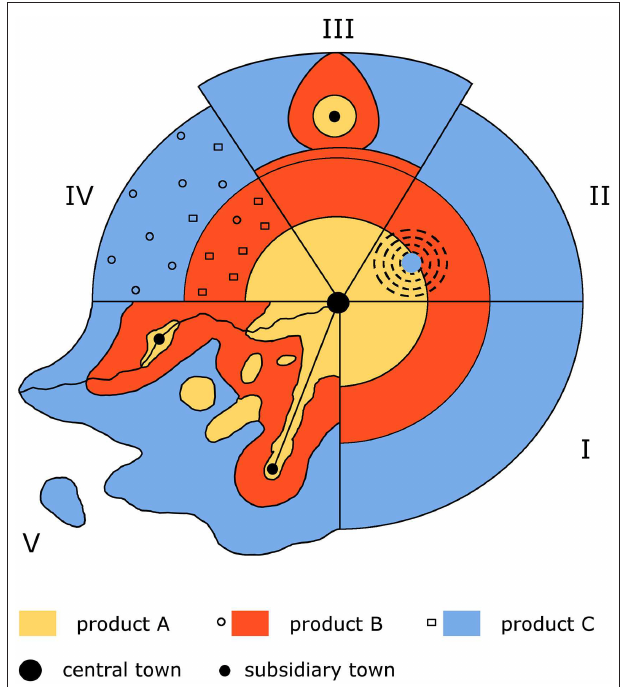
II shows how differences in the quality of soil can transpose the cultivation of certain products outside their “expected” zone; Segment III illustrates the influence of a second market; Segment IV shows the effect of peasant farmers on the model as they tend to grow products based on their personal needs rather than market principles; Segment V introduces a combination of variables including roads, rivers, minor centers, and uneven geography, which is closest to the real-world scenario (redrawn after Pred, 1967, p. 26, Figure 8.6).